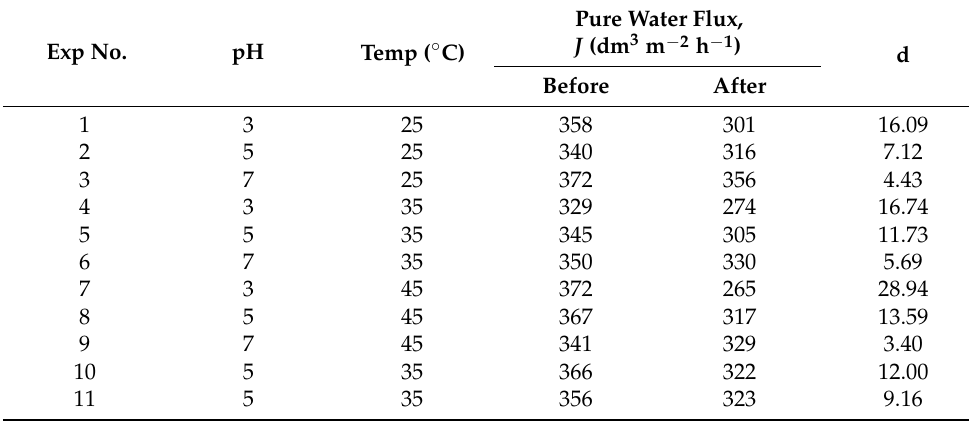
Table 6. Pure water flux measurements before and after